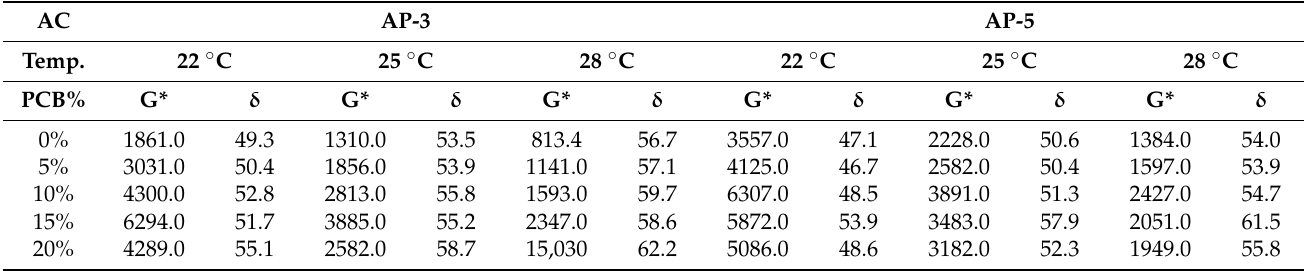
Table 7. Measured shear modulus and phase angle for long-term aged asphalt